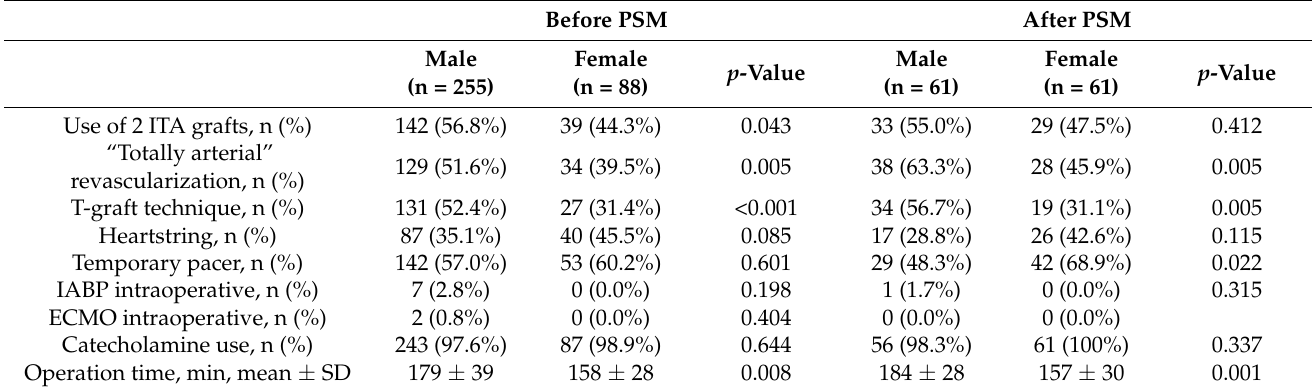
Table 2. Intraoperative data.